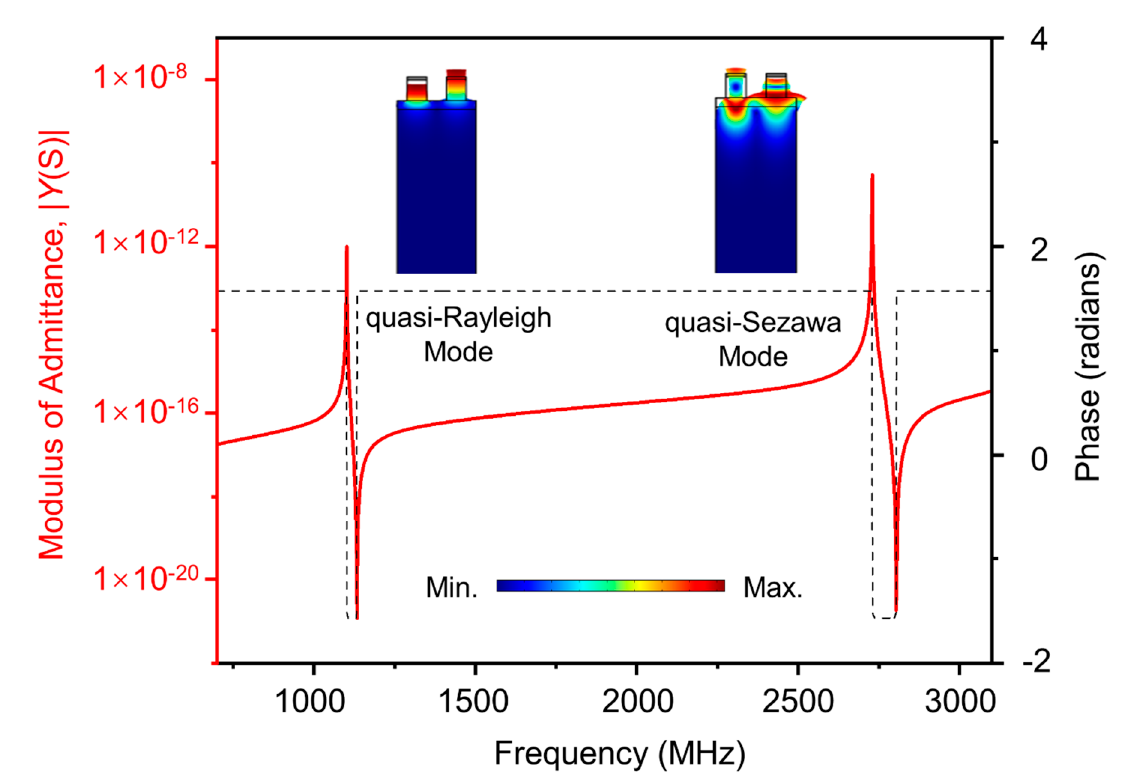
Figure 2. Typical simulated admittance spectra | Y (S)| of the partially etched ZnO/SiC configuration at h / λ = 0.6 and d / h = 0.7; the insets show the COMSOL-simulated mode shape of each mode.